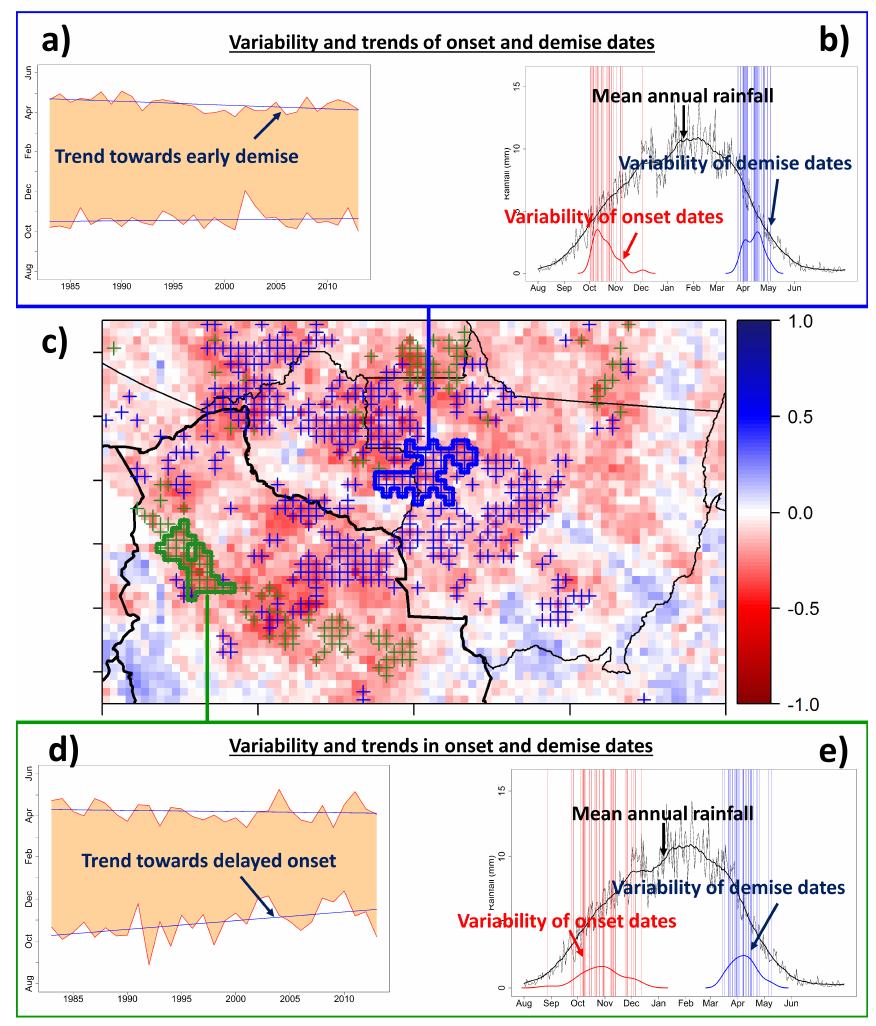
Figure 9. The central map shows trends in the duration of the rainy season ( τ value) with significant trends of delayed onset (green crosses) and early demise (blue crosses). The top and bottom parts show the 31-year variability and trends for the onset and demise dates at two locations, in Bolivia and at the border between Rondônia and Mato Grosso